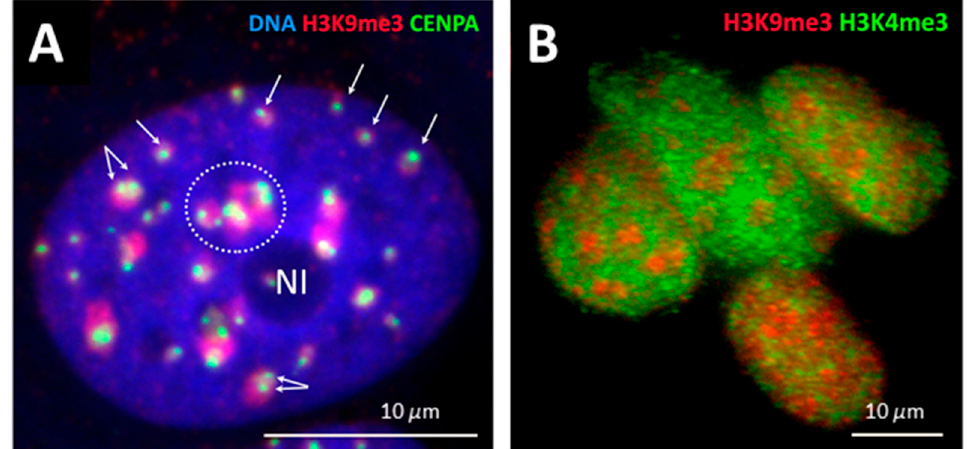
Figure 7. MCF-7 cells in chamber slides stained by immunofluorescence in 48 h starving control for: ( A ) PADs (H3K9me3), centromeres (CENPA), and DNA (NL—nucleolus) showing the unclustered and clustered centromeres in individual PADs (arrows and encircled); ( B ) PADs/H3K9me3 counterstained for active chromatin with H3K4me3 label. ( A ) Confocal and ( B ) epifluorescence microscopy. (Note: This figure was originally published under CC ‐ BY license in [41]).